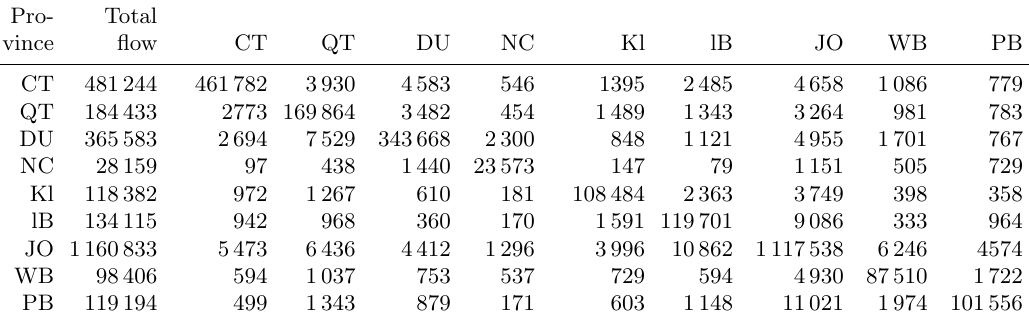
Table 3: Commuter flow within and between the last nine clusters. The following abbreviations are used: CT = Cape Town (combination of Western Cape and Northern Cape), QT = Queenstown (mostly Eastern Cape), DU = Durban (mostly KwaZulu-Natal), NC = Newcastle (combination of KwaZulu-Natal and Mpumalanga), KL = Klerksdorp (combination of Free State and North West), RB = Rustenburg (combination of North West and Northern Cape), JO = Johannesburg (mostly Gauteng, with parts of surrounding provinces included), WB = Witbank (remainder of Mpumalanga) and PB = Pietersburg (remainder of Limpopo Province). Total flow value within provinces: 2 533 676 (94.18%). Total flow value between provinces: 156 673